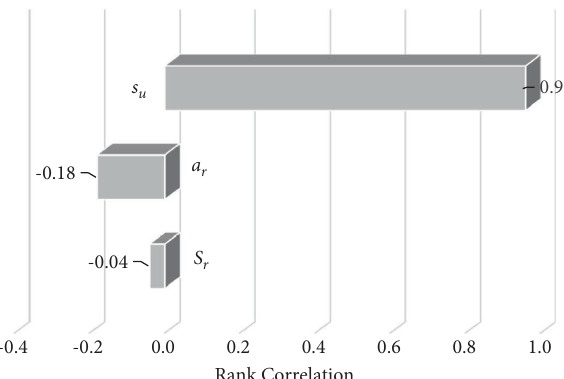
Figure 10: Tornado diagram of relative infuence of the input variables on diferences between MLR models (MLR